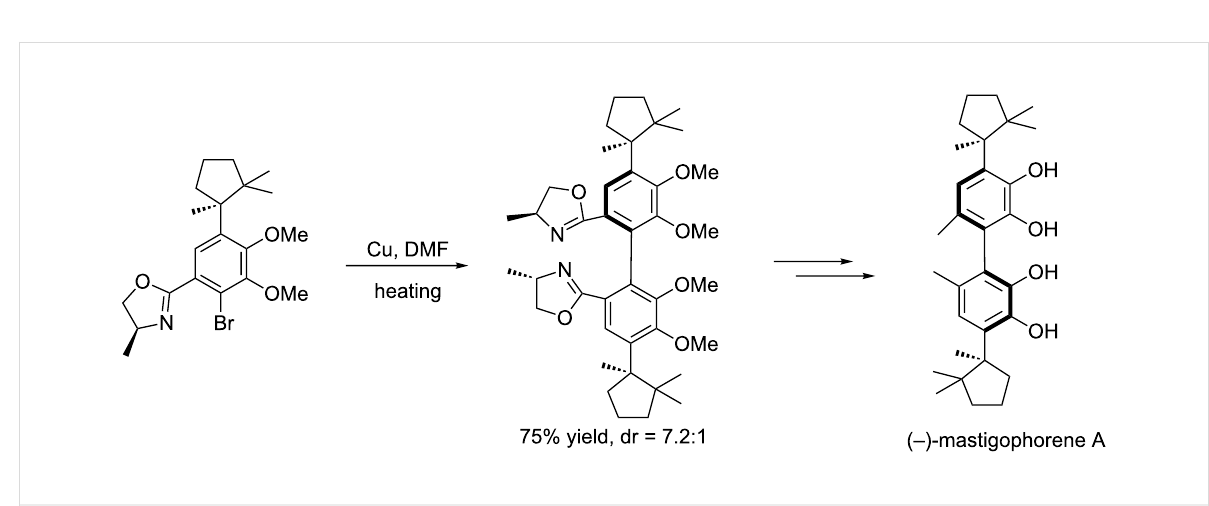
Scheme 7: Total synthesis of (+)-gossypol.